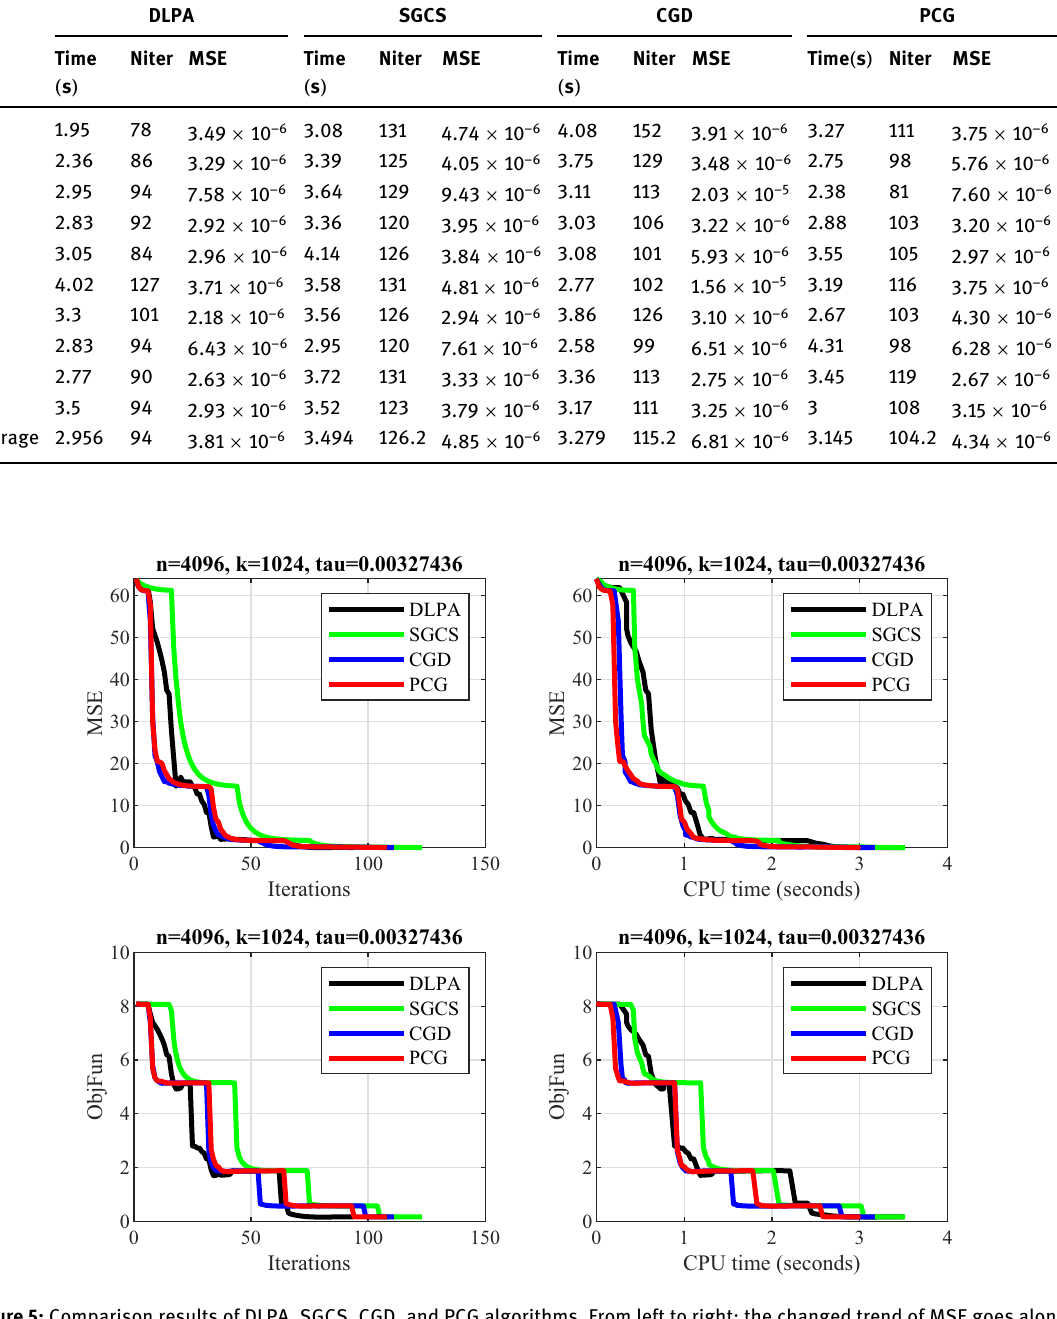
Figure 5: Comparison results of DLPA, SGCS, CGD, and PCG algorithms. From left to right: the changed trend of MSE goes along with the number of iterations or CPU time in seconds, and the changed trend of the objective function values accompany the number of iterations or CPU time in